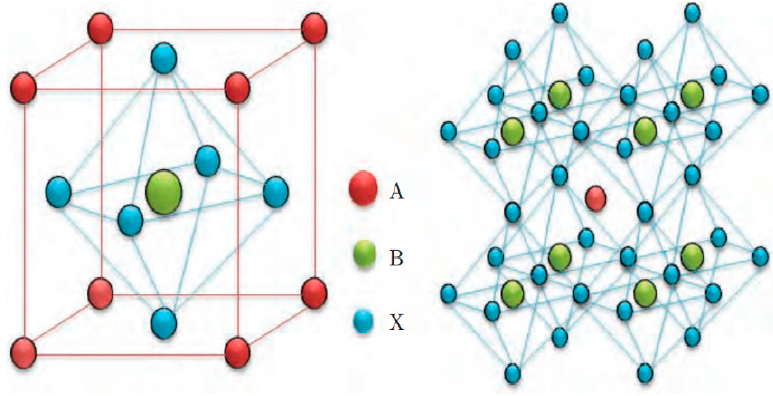
Figure 1. Crystal structure of perovskite [8].